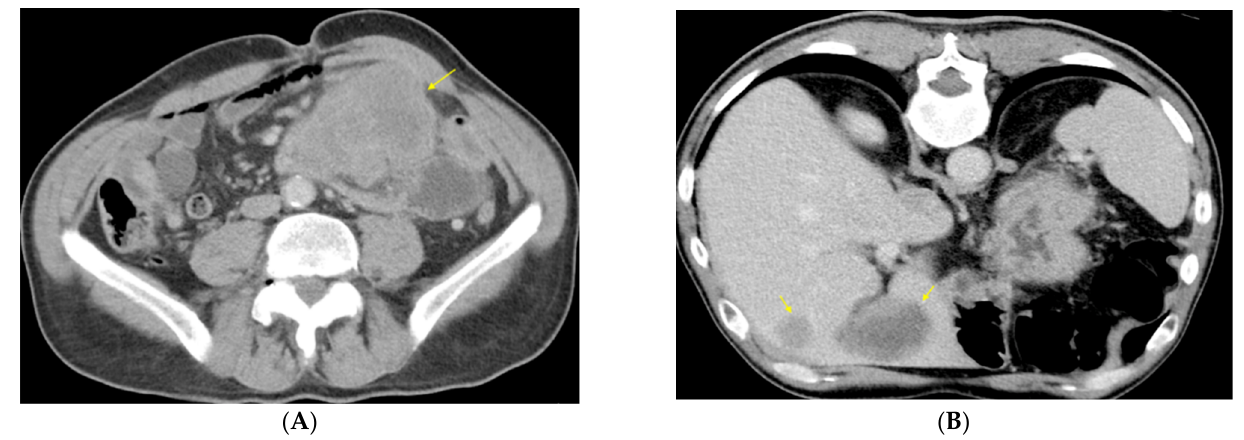
Figure 1. Abdominal CT scan at the first diagnosis, with i.v. administration of contrast material (venous phase shown): ( A ) large heterogeneous, hypoenhancing mass with infiltrative growth located in the left flank near jejunal loops and descending colon; ( B ) liver nodules/metastases hypoattenuating on unenhanced CT (not shown), enhancing at their periphery but less than surrounding liver parenchyma following contrast administration (A-yellow arrows).